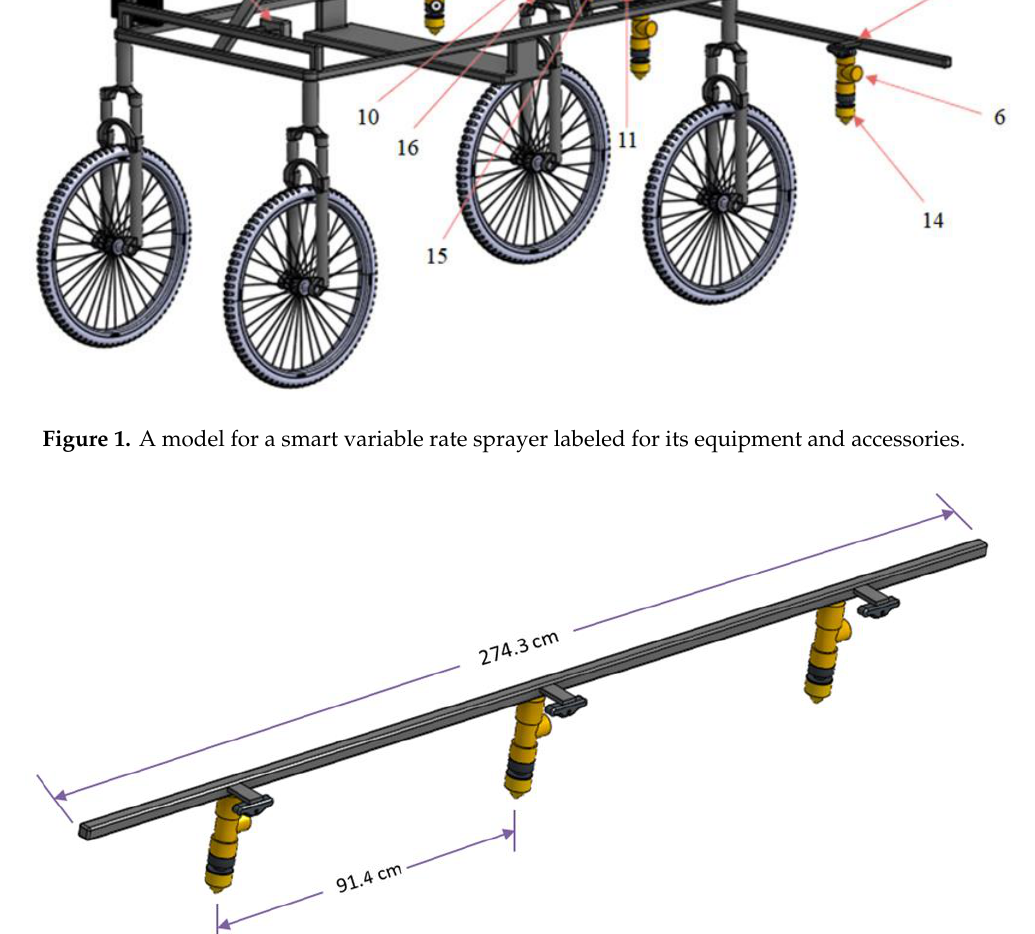
Figure 1. A model for a smart variable rate sprayer labeled for its equipment and accessories.